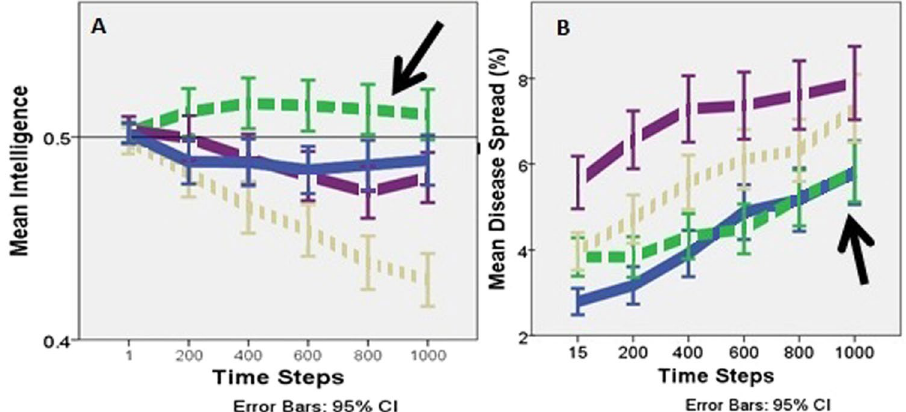
Figure 2. Change over time in the small communities’ mean population intelligence (A) and disease spread (B) . The arrows highlight that only the kin-based communities (green medium dashes) show an increase in mean population intelligence over time (A) and disease spread that approximates the spread in the basal primate communities (solid blue line) (B) . The reference line at 0.5 (A) highlights the average intelligence of the populations at the start of the model runs. In the model, disease recognition is a function of intelligence, thus an increase in intelligence reflects selection for disease recognition and care-giving. The kin-based communities are shown with a medium dashed line, basal primate in a solid blue line, pair-bonded in a short grey dashed line, and indirect reciprocity in a long purple dashed line.